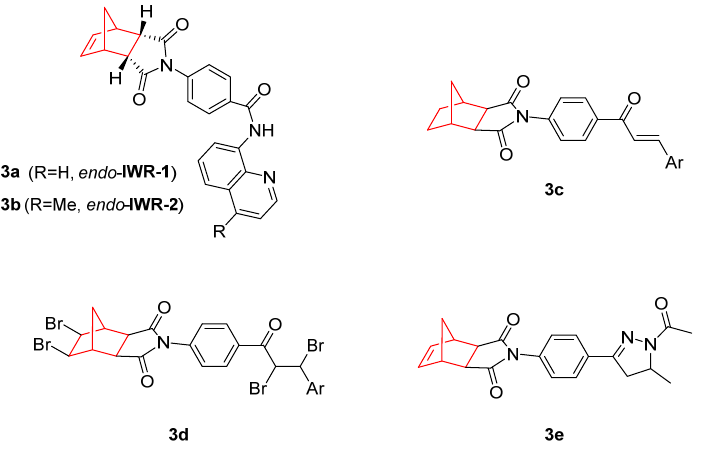
Figure 3. Wnt response inhibitors containing norbornene [34–38] (compounds 3 a, 3b ). Carbonic an